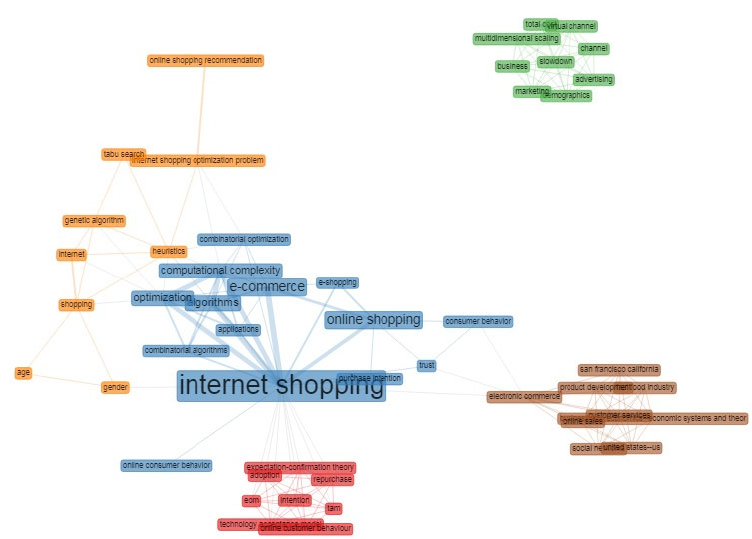
Fig. 8. Clusters of Term Based on Louvain's Method